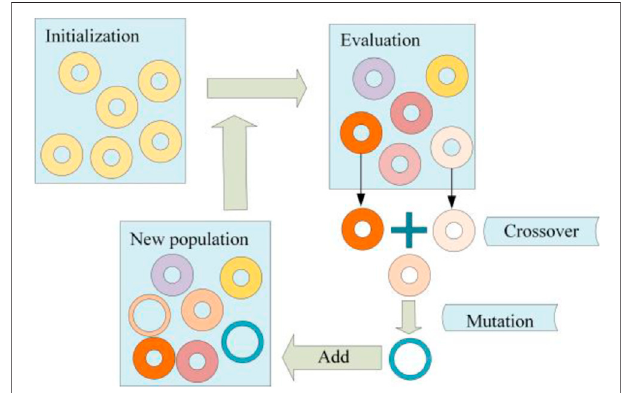
FIGURE 4 | The graph of knowledge transfer in multi-task learning. The chart only shows the process of knowledge transfer between two tasks.